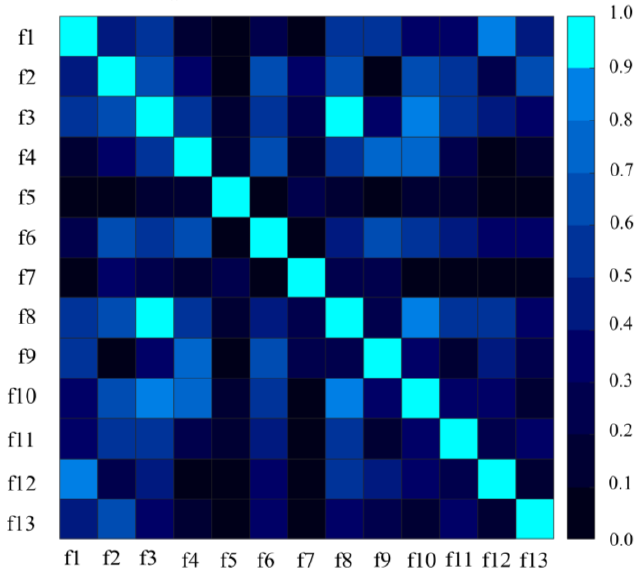
Figure 4. The absolute value of the Spearman correlation between the extracted features from the FP SAR data. Please note that 0 and 1 indicate zero and the highest correlation, respectively.